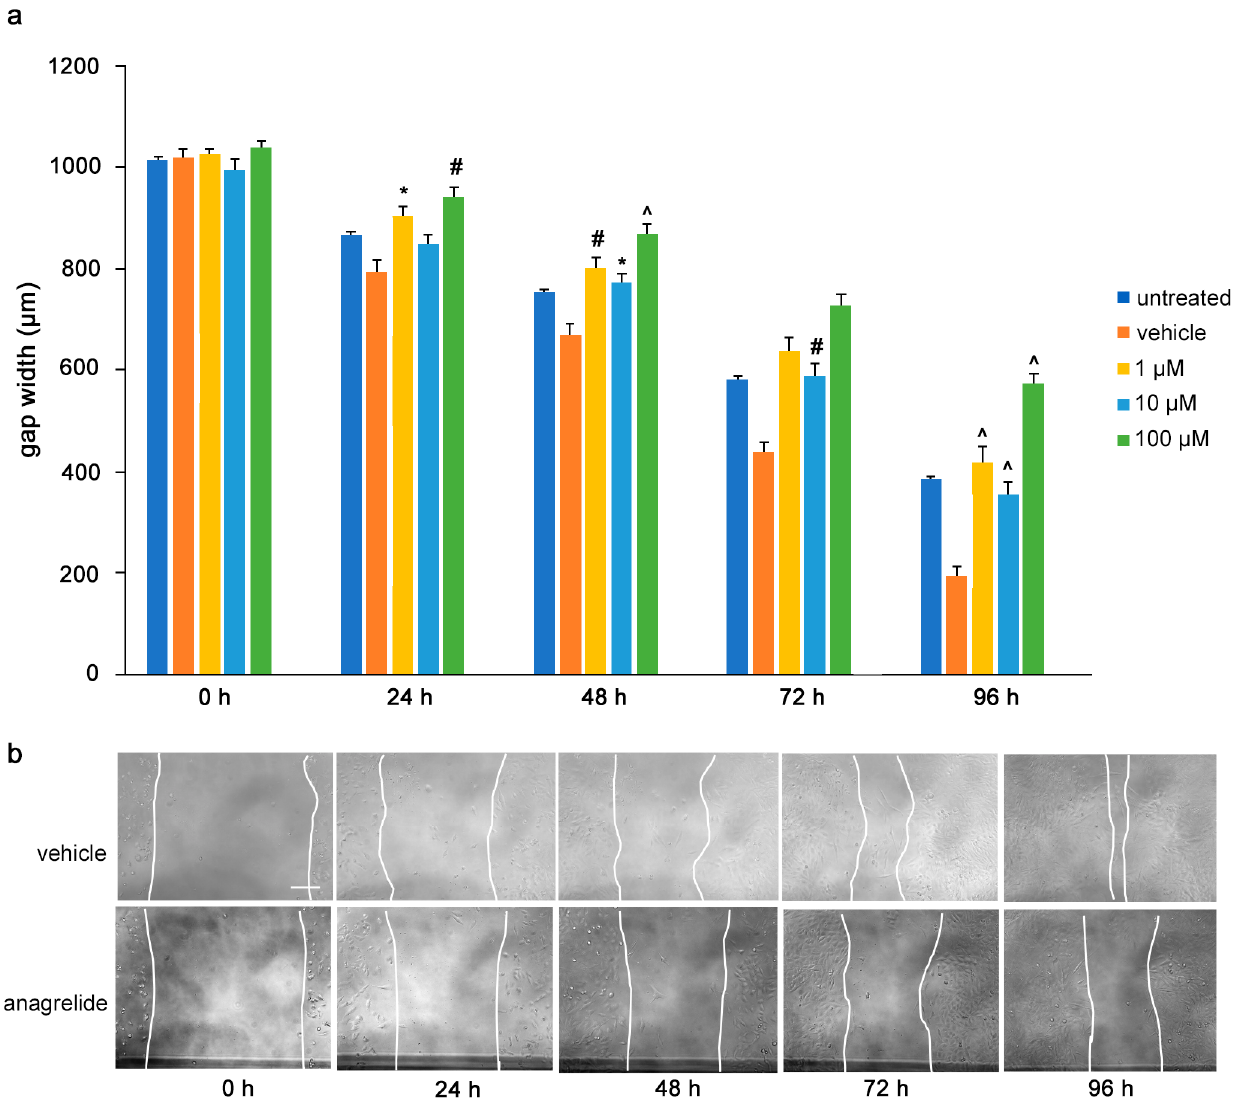
Figure 3. Anagrelide inhibits migration of U251 cells. U251 cells were seeded in 96-well plates. After 24 h, monolayers were scratched, immediately imaged, and then treated with different concentrations of anagrelide (1, 10 and 100 μ M). Cells were imaged every 24 h up to 96 h. ( a ) Graph represents the gap width ( μ m) of untreated cells, vehicle-treated cells and cells treated with vehicle or 100 μ M anagrelide. Two images were taken per well and values for each condition were averaged. Error bars show mean + SEM from 5 independent experiments. * p < 0.05, # p < 0.01, ^ p < 0.001 as determined by one-way ANOVA with Tukey’s post hoc test. ( b ) Representative images of anagrelide-treated and vehicle-treated cells. Scale bar for all images, 200 μ m in panel for vehicle-treated cells.